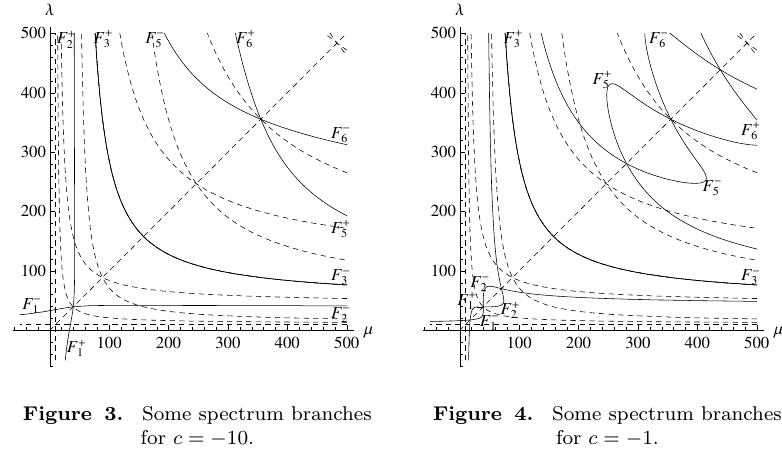
Figure 4. Some spectrum branches for c = −